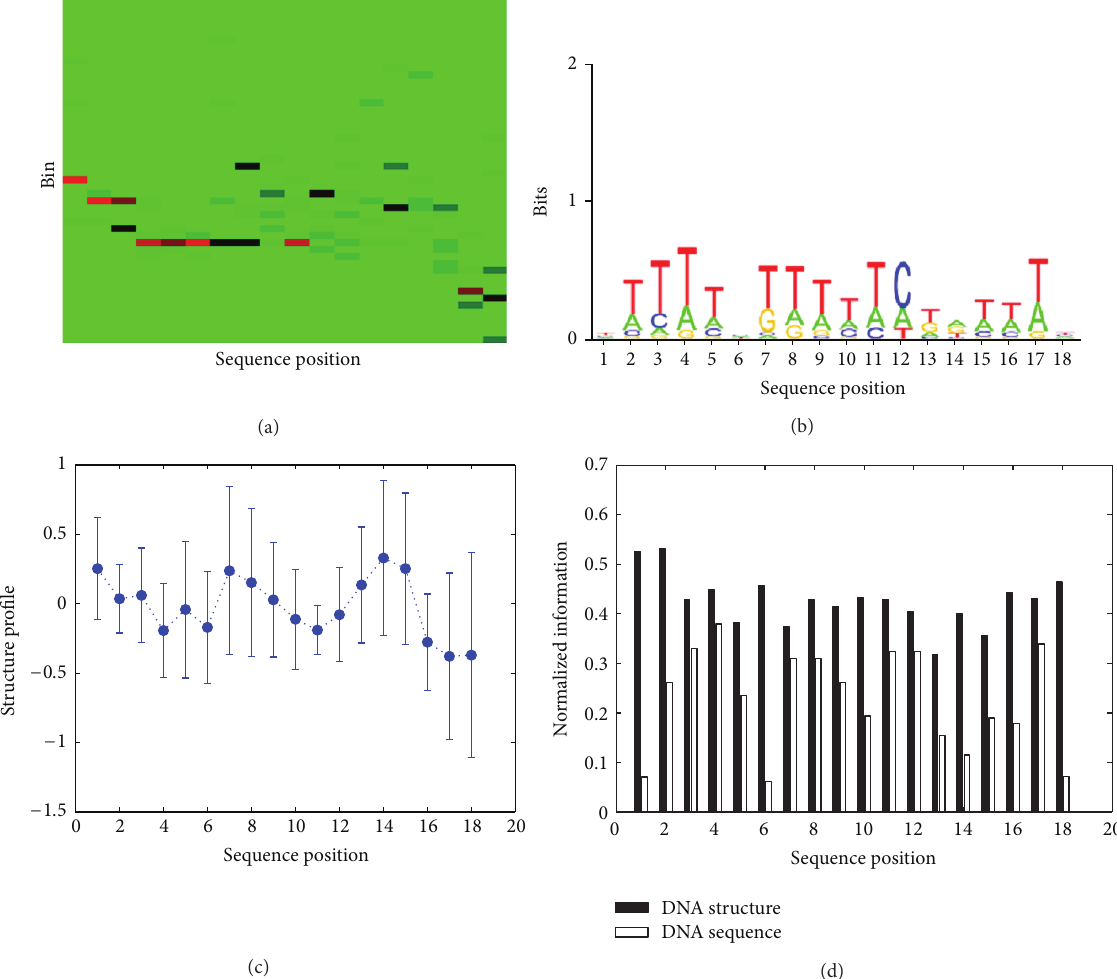
Figure 1: Analysis of the representative AZF1 consensus structural pattern. (a) Heat map of AZF1 consensus structural pattern found in putative TFBS. (b) Sequence logos of AZF1 found in putative TFBS. (c) Mean and standard deviation of predicted hydroxyl radical cleavage patterns. (d) Conservation of structure versus sequence in